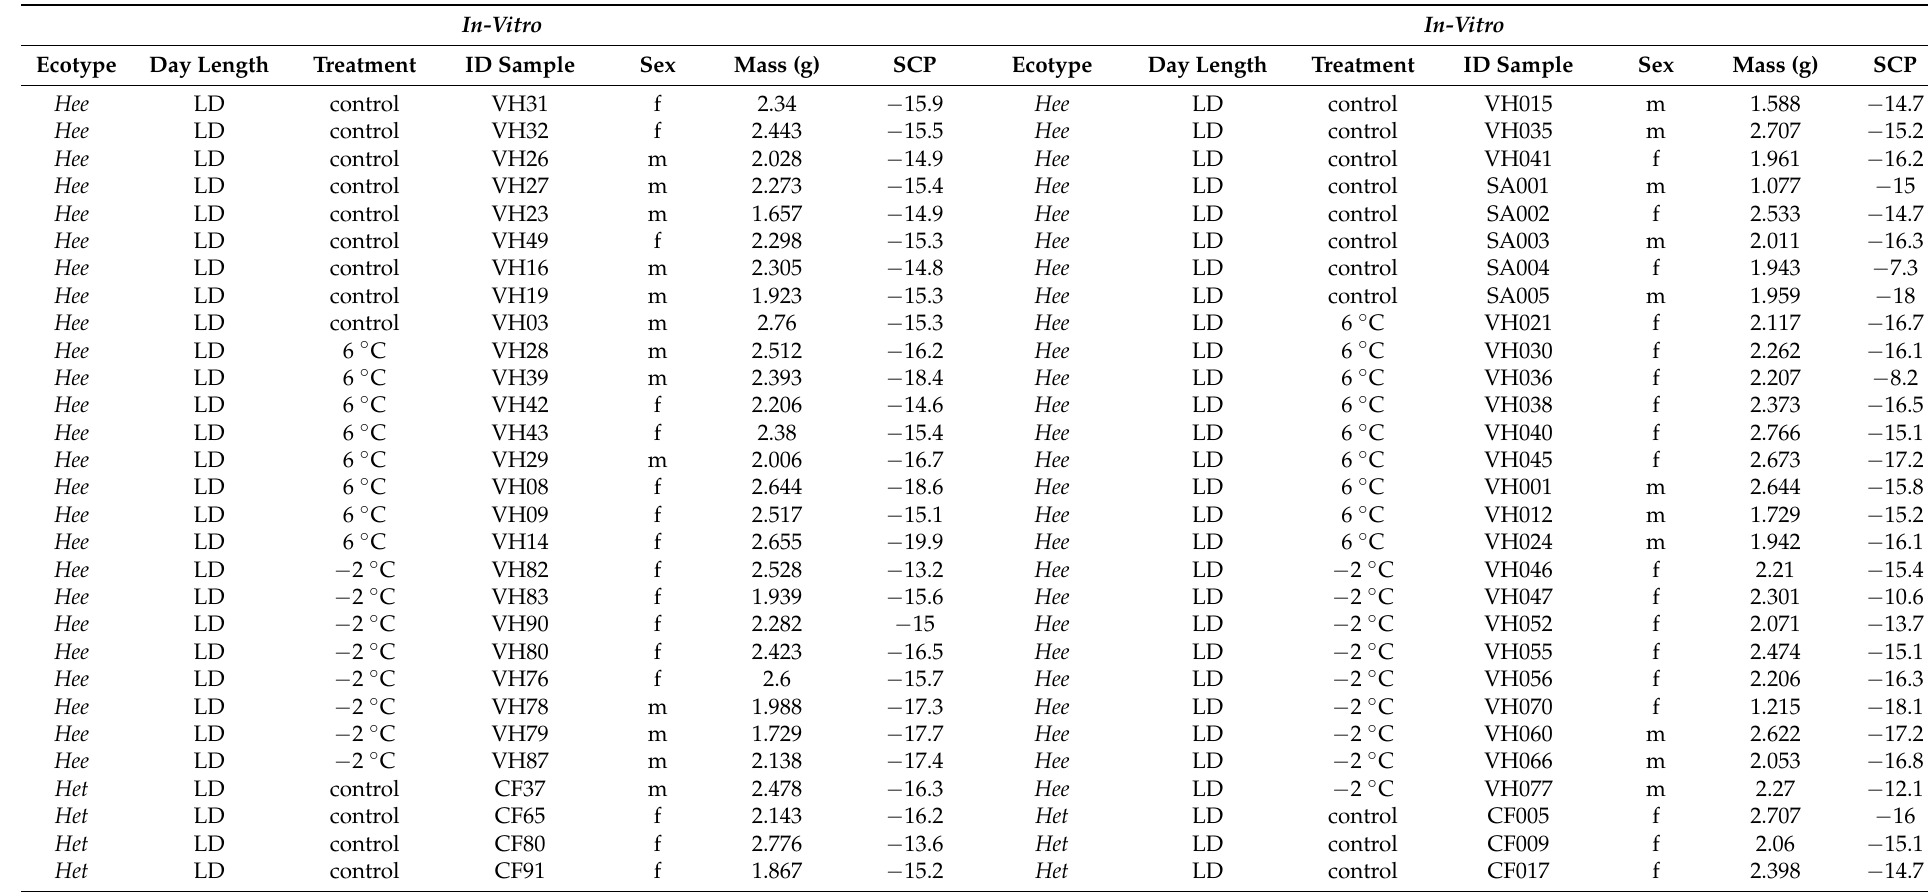
Table A1. Data of in-vitro and in-vivo supercooling point (SCP) measurements, including pupae mass and sex, as well as an original ID based on the locality code (see table in the original